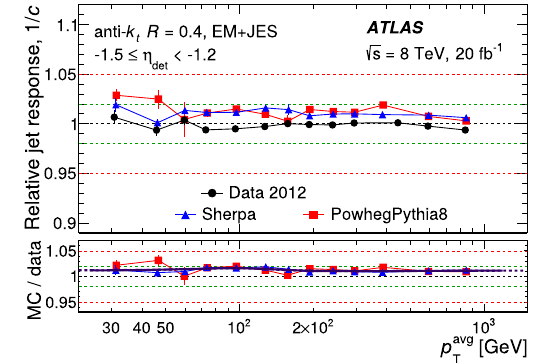
Fig. 18 Relative jet response, 1 / c , as a function of the jet p T for anti- k t jets with R = 0 . 4 calibrated with the EM+JES scheme, separately for − 1 . 5 ≤ η det < − 1 . 2 and 2 . 1 ≤ η det < 2 . 4, for data (black cir- cles), Sherpa (blue triangles) and Powheg+Pythia8 (red squares). The lower parts of the figures show the ratios of MC simulation to data